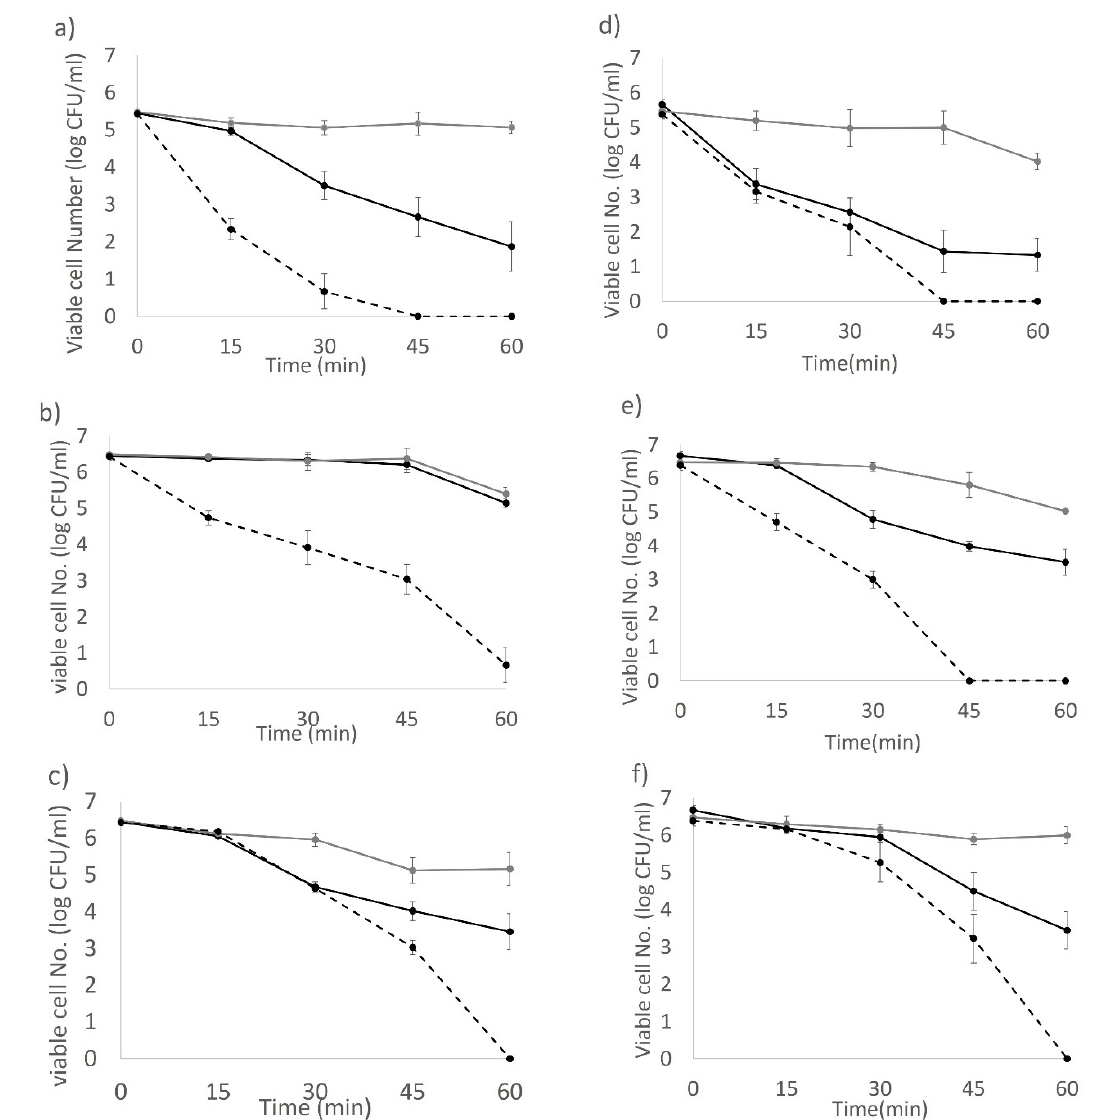
Figure 6. The combined effect of 0.02% H 2 O 2 and 180 J/cm 2 of light dose on three-day-old biofilm cells grown from 10% skim milk. ( a ) BAA894 biofilm on stainless steel; ( b ) ES191 biofilm on stainless steel; ( c ) AGRFS2961 biofilm on stainless steel; ( d ) BAA894 biofilm on plastic; ( e ) ES191 biofilm on plastic; ( f ) AGRFS2961 biofilm on plastic; , control groups (with 0.02% H 2 O 2 );